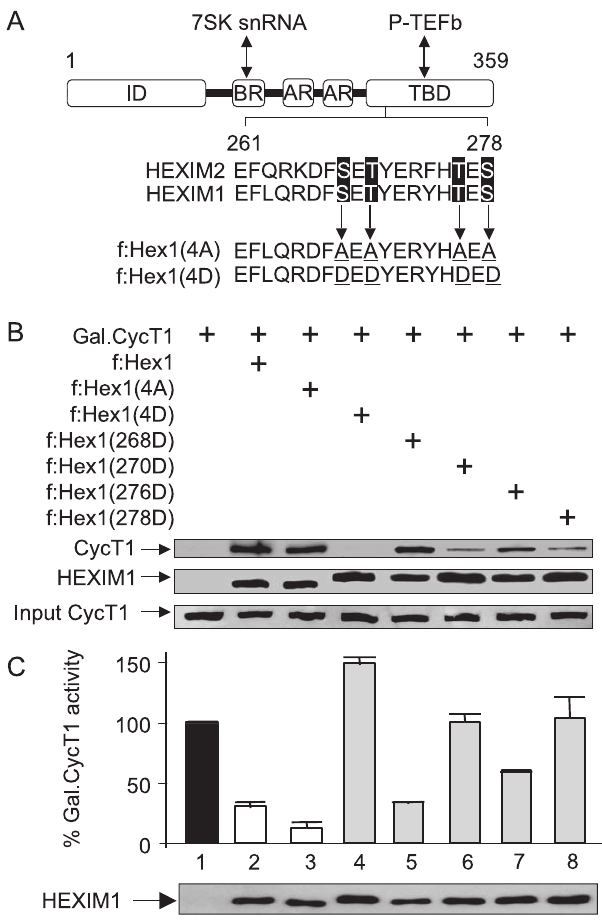
Figure 5. Mutant f:Hex1(4D) Protein Is Functionally Inactive (A) Schematic representation of HEXIM1. Sequences are representative of mutant f:Hex1(4A) and f:Hex1(4D) proteins. Mutations are underlined. ID: inhibitory domain; BR: basic region; AR: acidic region; TBD, CycT-binding domain. (B) Extracts prepared from Jurkat cells transfected with an empty plasmid vector or those expressing f:Hex1, mutant f:Hex1(4A), or f:Hex1(4D) proteins, or point mutant f:Hex1(268D), f:Hex1(270D), f:Hex1(276D), or f:Hex1(278D) proteins, were subjected to anti-Flag immunoprecipitation. Levels of endogenous CycT1 protein bound to Flag epitope-tagged mutant HEXIM1 proteins are indicated in the upper panel. The middle panel represents levels of Flag epitope-tagged mutant HEXIM1 proteins expressed in Jurkat cells and the lower panel shows the input of CycT1. (C) Jurkat cells were co-transfected with the reporter plasmid pG6TAR (0.4 l g) and, where indicated, with the plasmids expressing Gal4.CycT1 (0.6 l g), f:Hex1 (0.8 l g), f:Hex1(4A) (0.8 l g), f:Hex1(4D) (0.8 l g), f:Hex1(268D) (0.8 l g), f:Hex1(270D) (0.8 l g), f:Hex1(276D) (0.8 l g), or f:Hex1(278D) (0.8 l g). Error bars represent the mean þ / (cid:2) SD. Lower panel presents the levels of Flag epitope-tagged HEXIM1 proteins expressed in Jurkat cells.